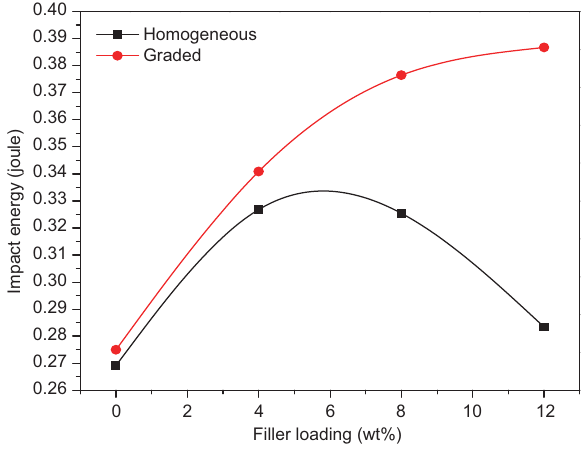
Figure 4 Variation of impact strength on filler loading of